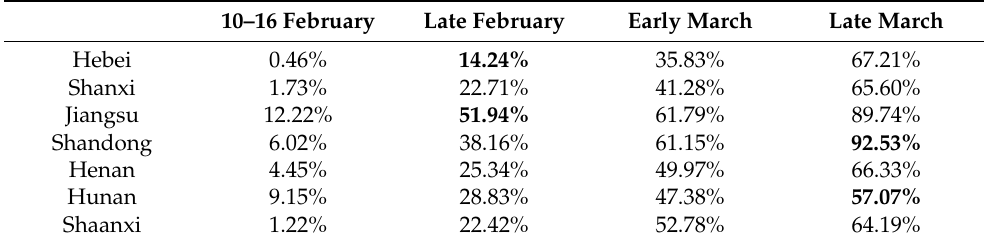
Table 2. The work resumption index of 7 provinces.